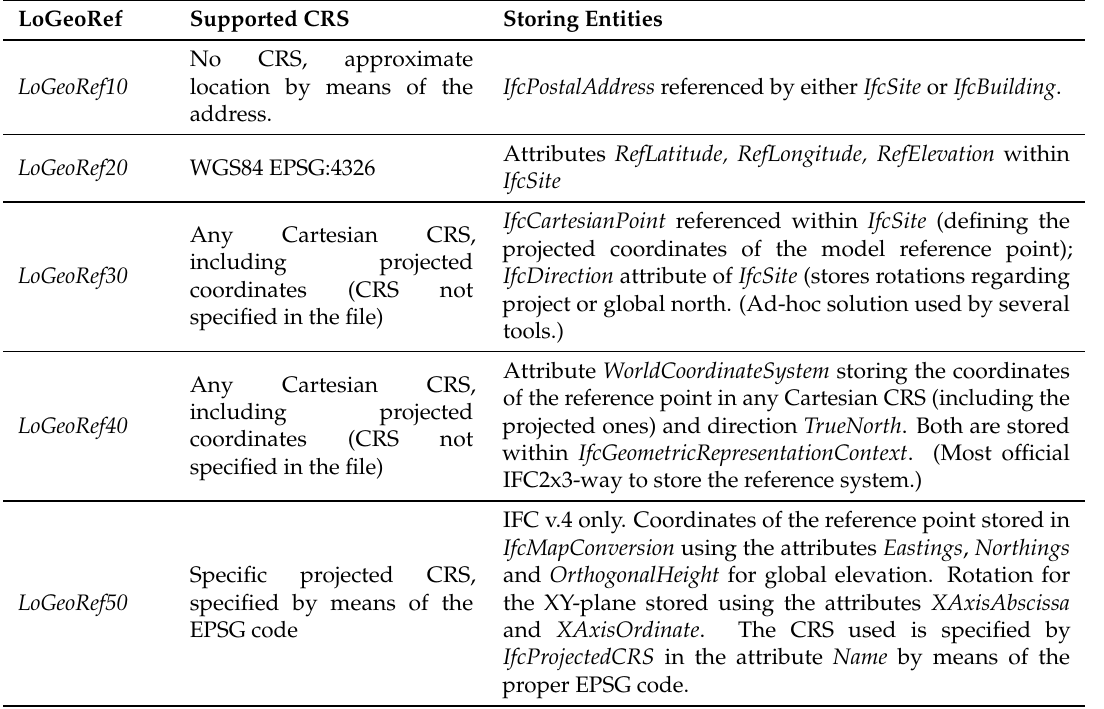
Table 2. List of georeferencing options in Industry Foundation Classes (IFC) classified as LoGeoRefs